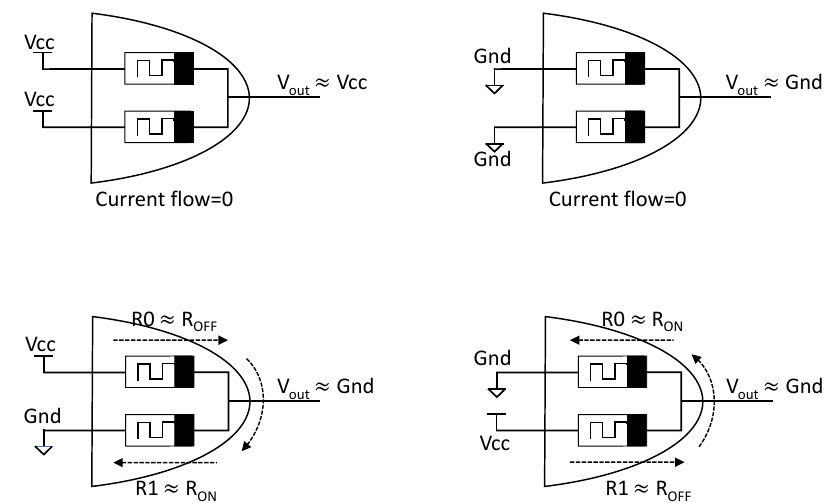
Figure 6. Logical operations performed with MRL AND